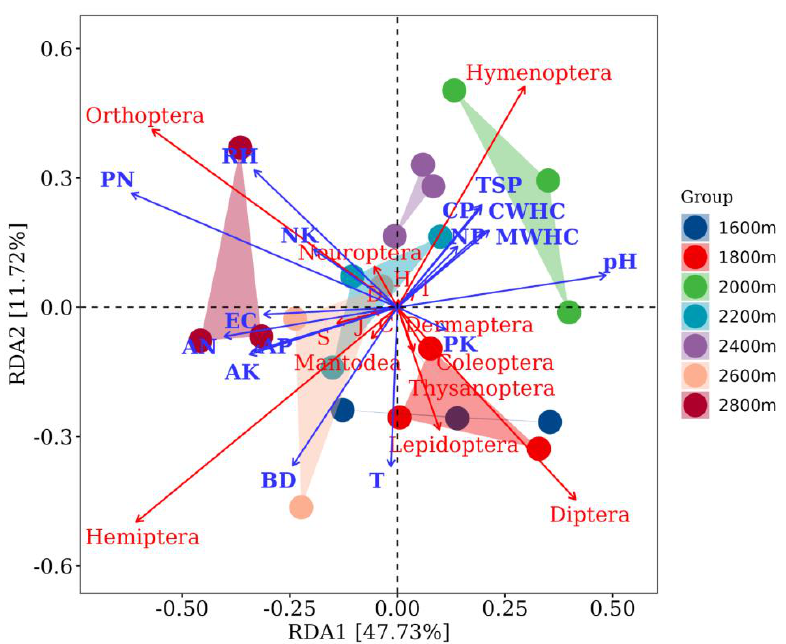
Figure 8. Redundancy analysis of the insect taxa order with soil factors in the Guandi Mountain. The red letters indicate the insect orders investigated in this study. The blue letters indicate the